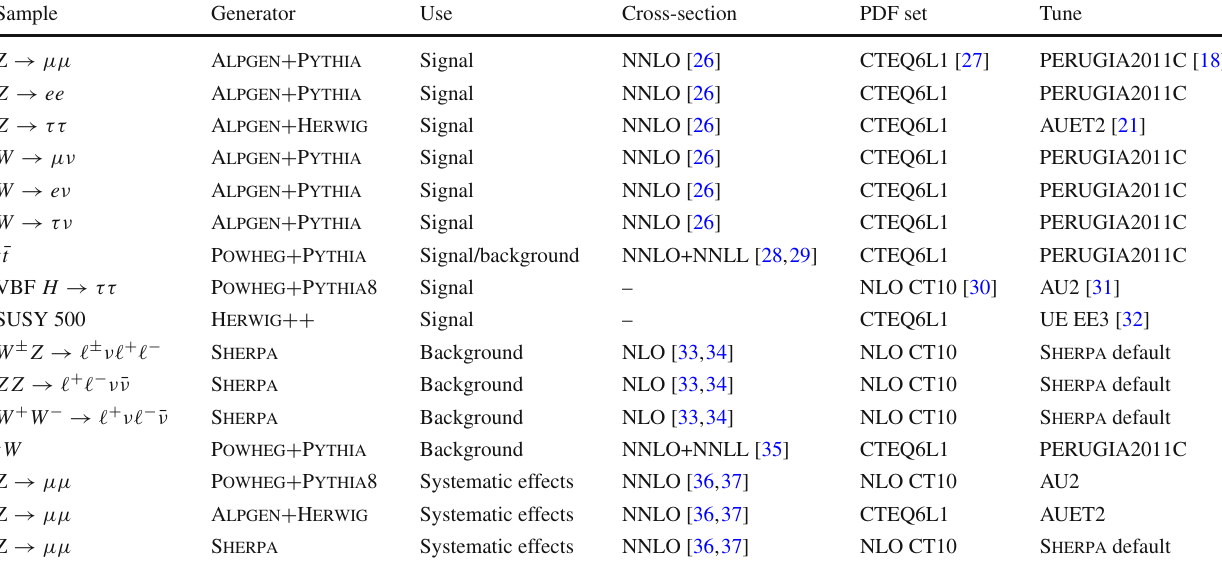
Table 2 Generators, cross-section normalizations, PDF sets, and MC tunes used in this analysis